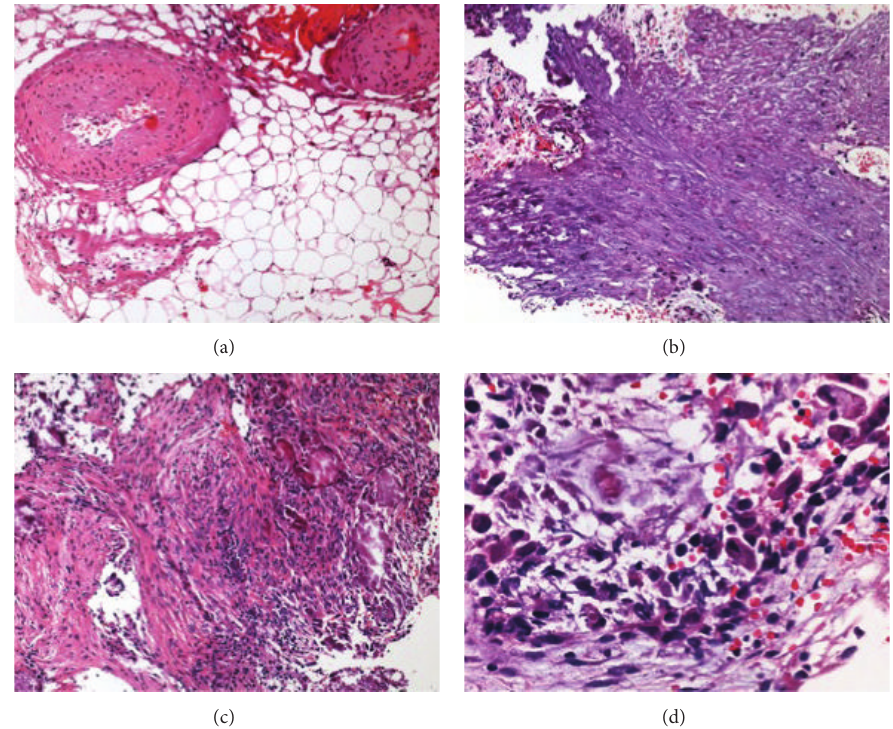
Figure3:(a)Histologicalfindingsrevealmatureadiposetissuewithasmallamountofcollagenandthickenedbloodvesselsfromtheyellowish tumor. (b, c) Greyish tumor shows marked calcification in most parts (b) and spindle-shaped cells in the sheet (c). Infiltration of mononuclear inflammatory cells along with immature cells showing hyperchromatic nuclei. Hematoxylin and eosin: (a–c) × 100; (d) × 400.